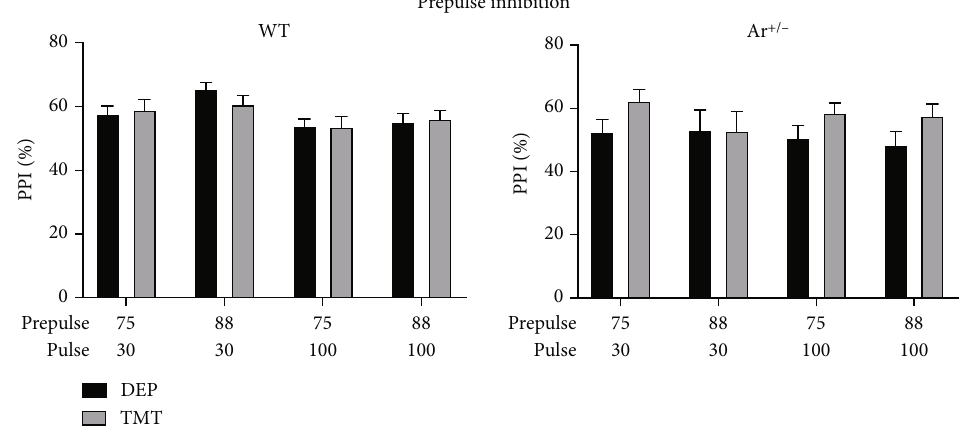
Figure 4: TMT exposure had no in fl uence on the PPI in WT mice and Ar+/- mice. Animals were tested with various white noise level/interval time combinations (75 dB/30ms, 88 dB/30 ms, 75dB/100 ms, and 88dB/100